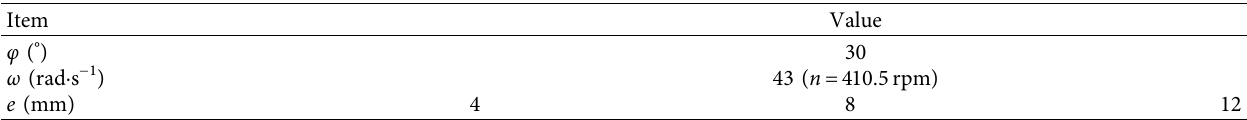
Figure 9: Dynamic characteristics along Y -direction under different rotational speed between experiments and theoretical calculations. Table 2: Parameters used in section